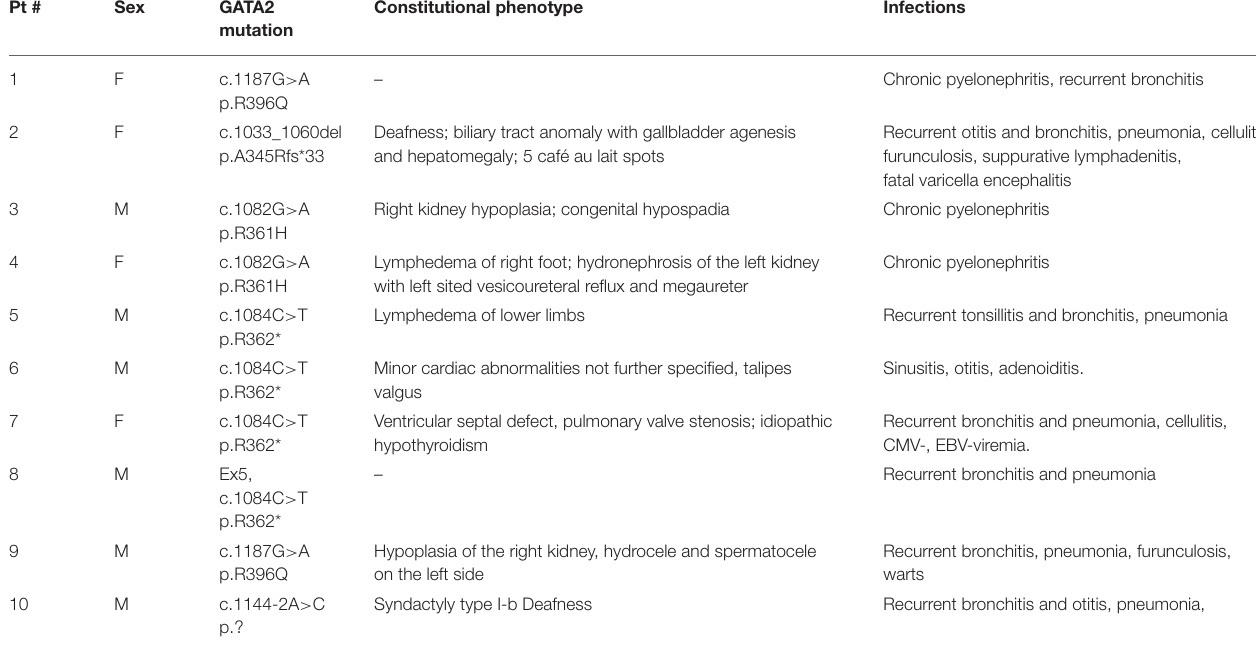
TABLE 2 | Constitutional phenotype and